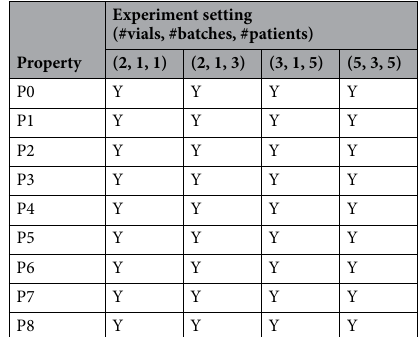
Experiment setting (#vials, #batches, #patients) Property